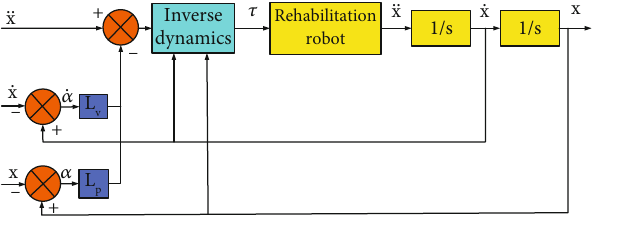
Figure 6: Calculated moment method.